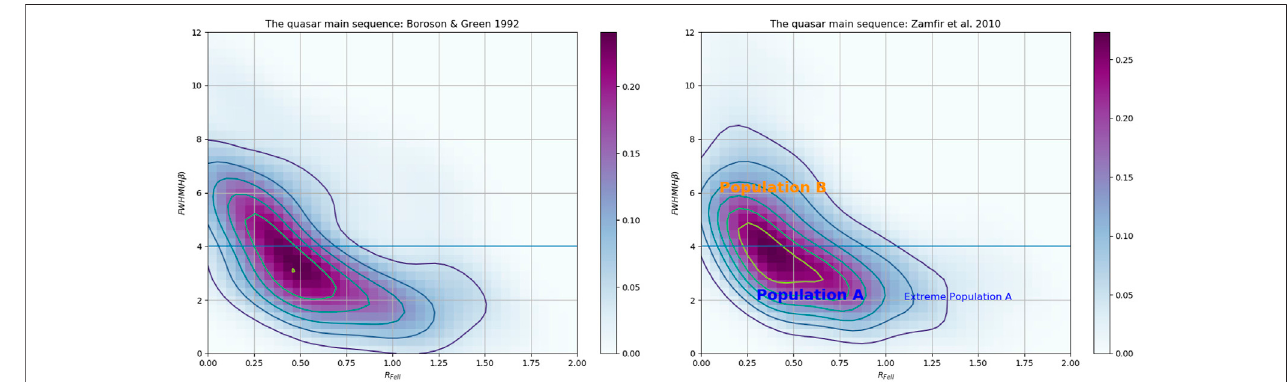
FIGURE 11 | The quasar main sequence as de fi ned from the original paper by Boroson and Green (1992) based on 88 quasars (left) and the one based on the SDSS sample of 310 low- z quasars by Zam fi r et al. (2010). The color shading from cyan to navy blue is proportional to the number density as a function of the Fe II prominence parameter and of the FWHM of H β , and therefore to the source occupation in the parameter